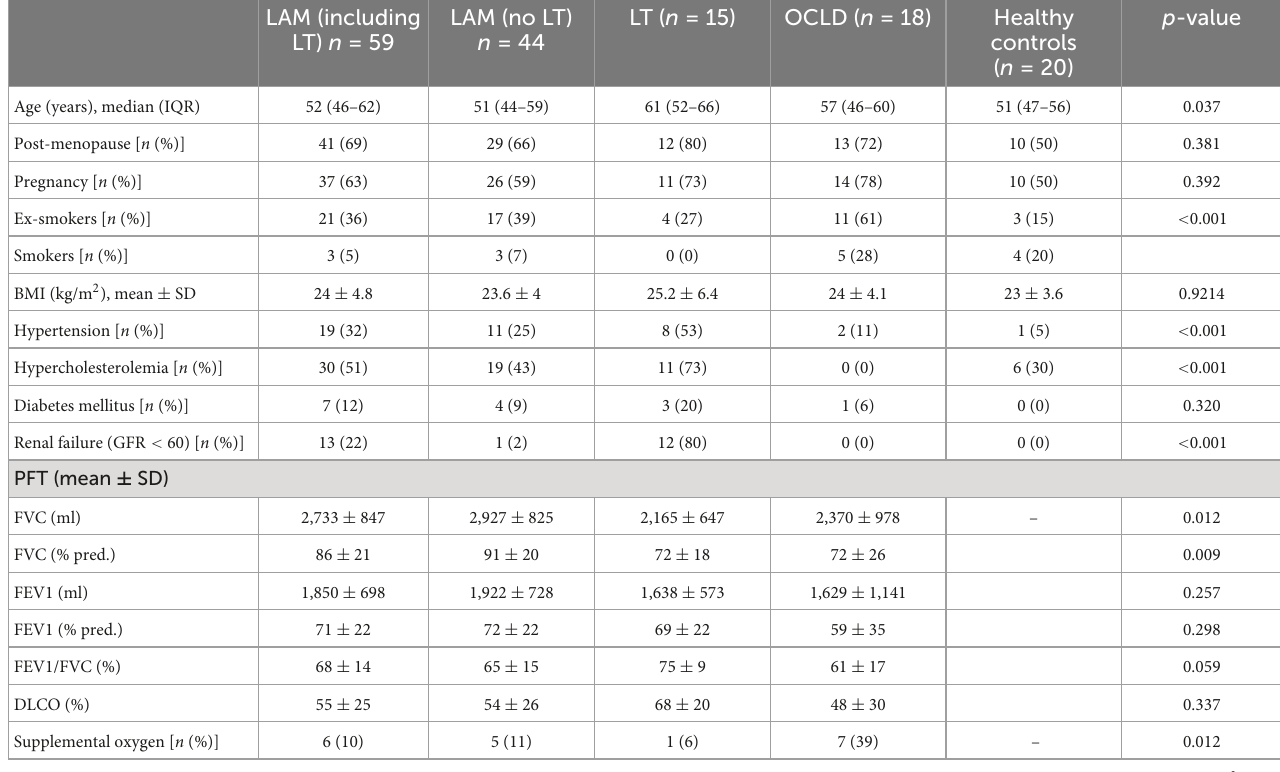
TABLE 1 Demographic and clinical characteristics of the study